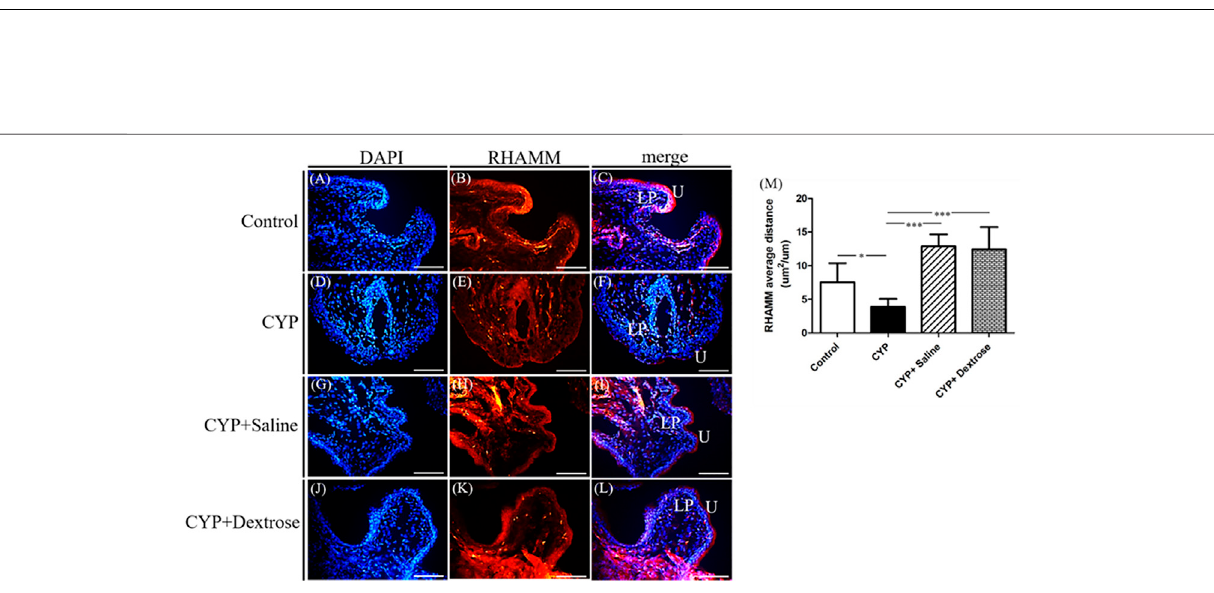
results, the red fl uorescence stain referred to as positive for HA receptors, by dividing hyaluronic acid-mediated motor receptors with the urothelial length ( μ m 2 / μ m) outside the urothelium. The distribution of CD44 expression and RHAMM receptors was found in both the upper layer of the urothelium and the lamina propria of the bladder ( Figures 4C ,F,I,L, 5C ,F,I,L). The intensity of the CD44 fl uorescence both in the CYP-saline and CYP-